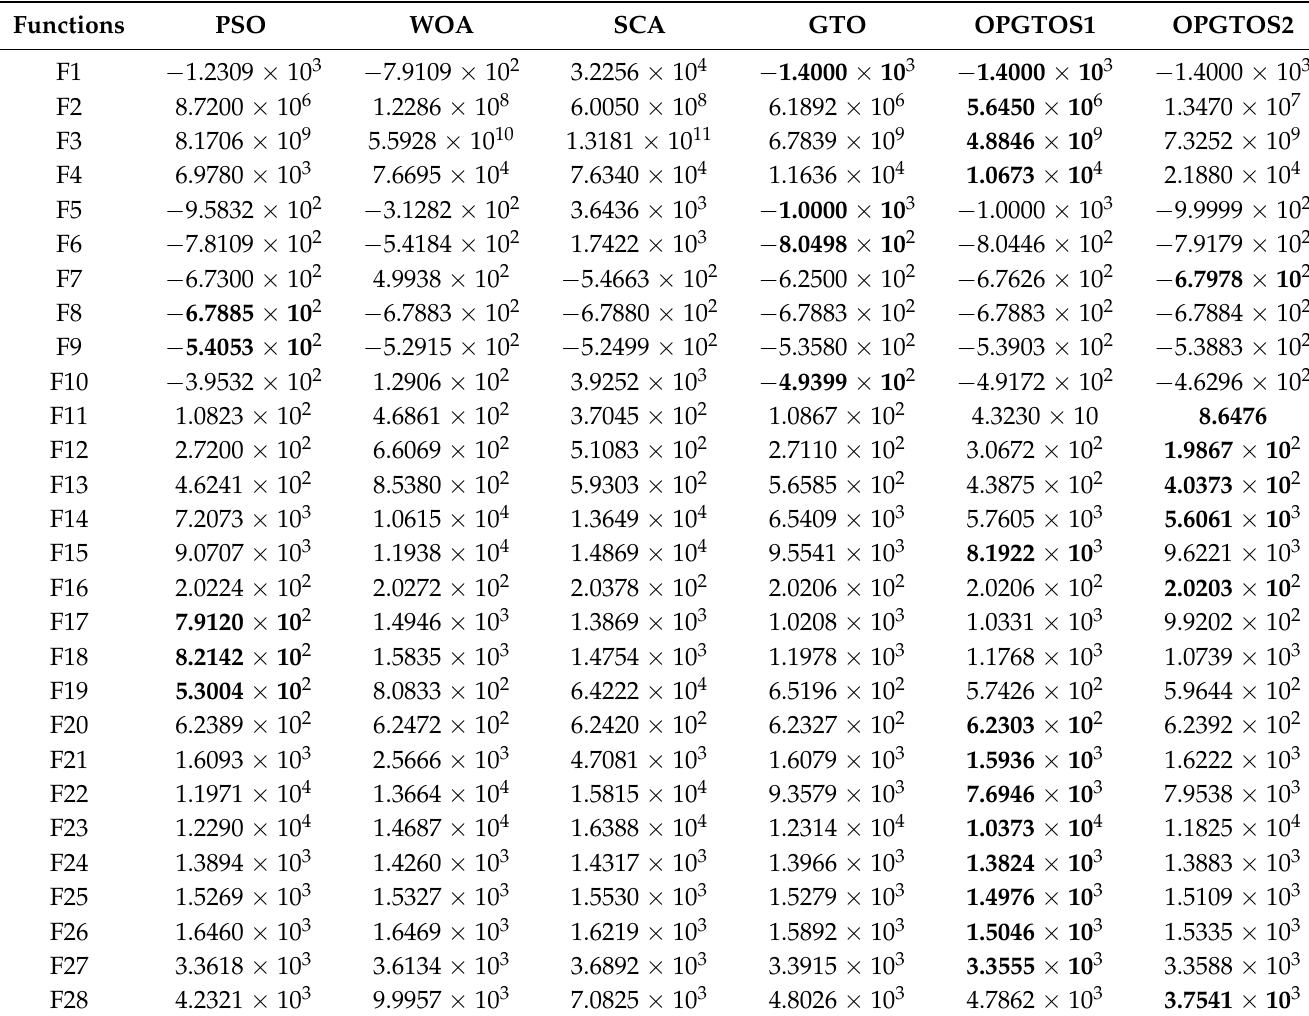
Table 4. Simulation results of CEC2013 functions in 50